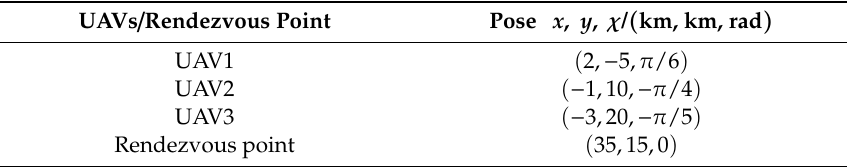
Table 2 . Desired formation configuration. Table 2. Desired formation configuration.